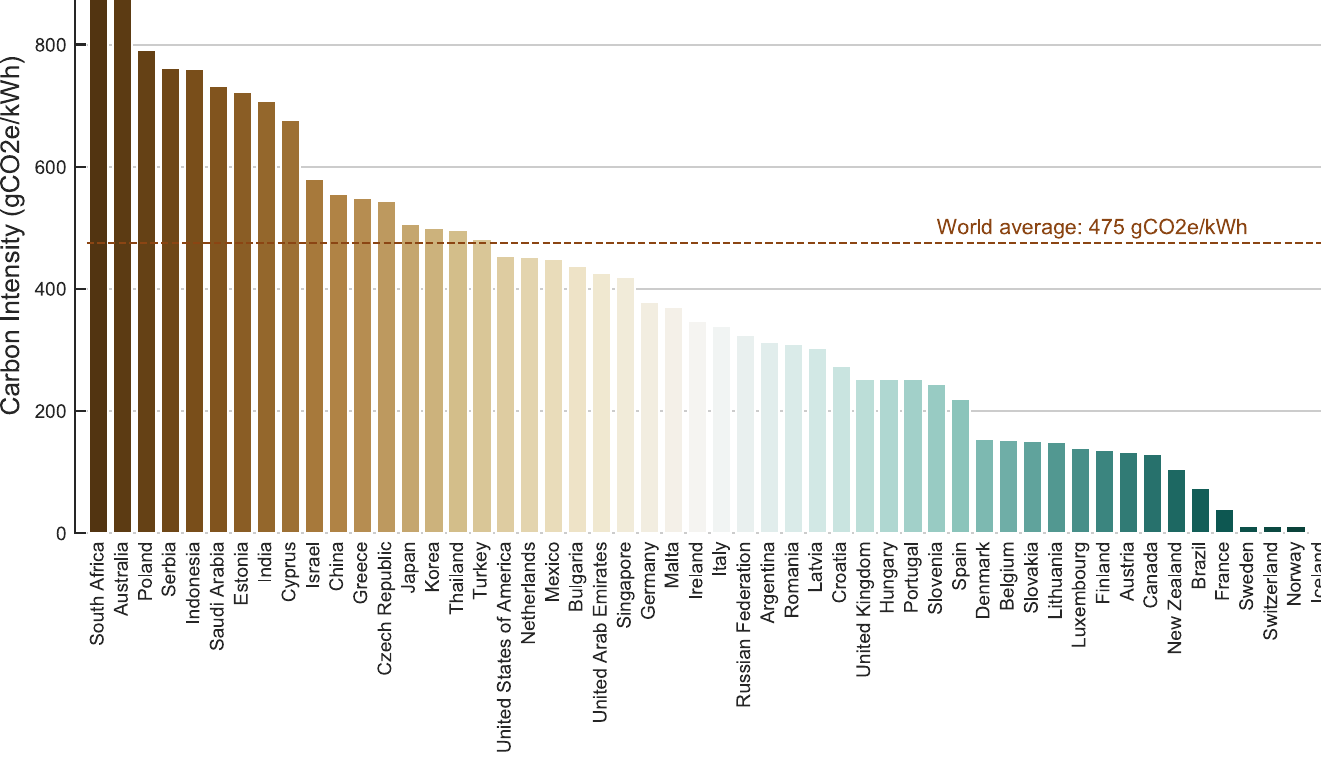
Fig 1. Carbon intensity (i.e., the carbon footprint of producing each kWh of electricity) for different countries, in gCO 2 e/kWh